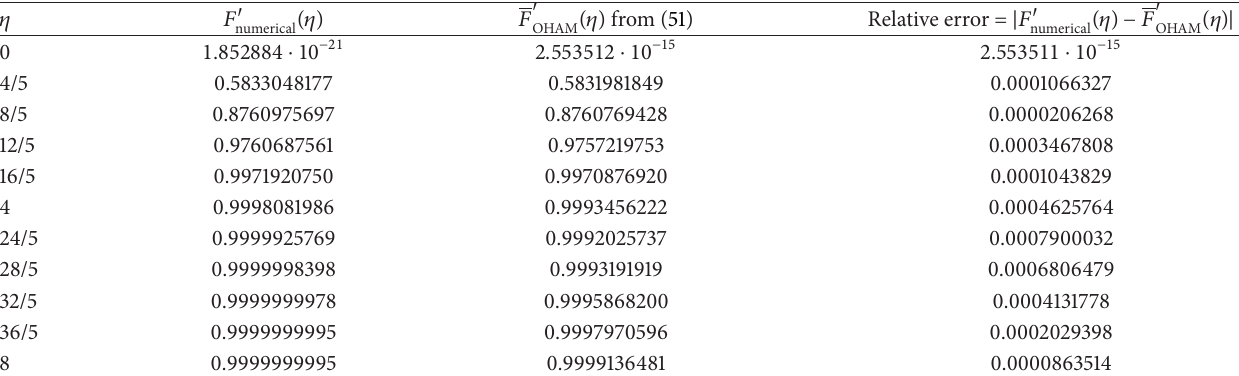
󸀠 (𝜂) obtained from (51) and numerical results for 𝛽 = 1/2